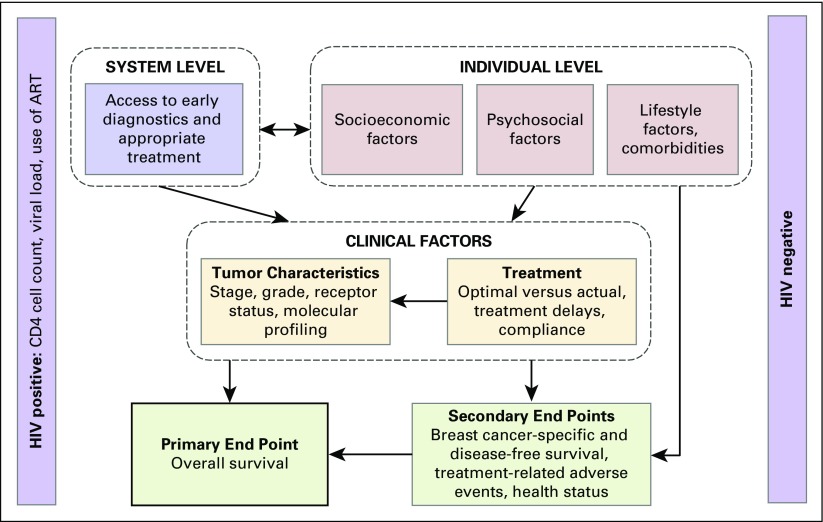
Causal pathways under investigation within the South African Breast Cancer and HIV Outcomes study for breast cancer survival among HIV-positive and HIV-negative women. ART, antiretroviral therapy.